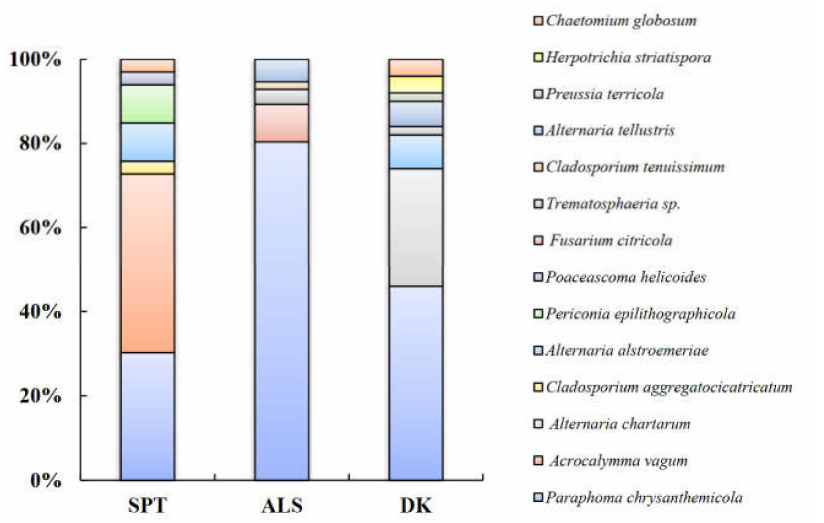
Figure 4. Column chart of the proportion of DSE species at three sample sites. Note: SPT, Shapotou. ALS, Alxa. DK,